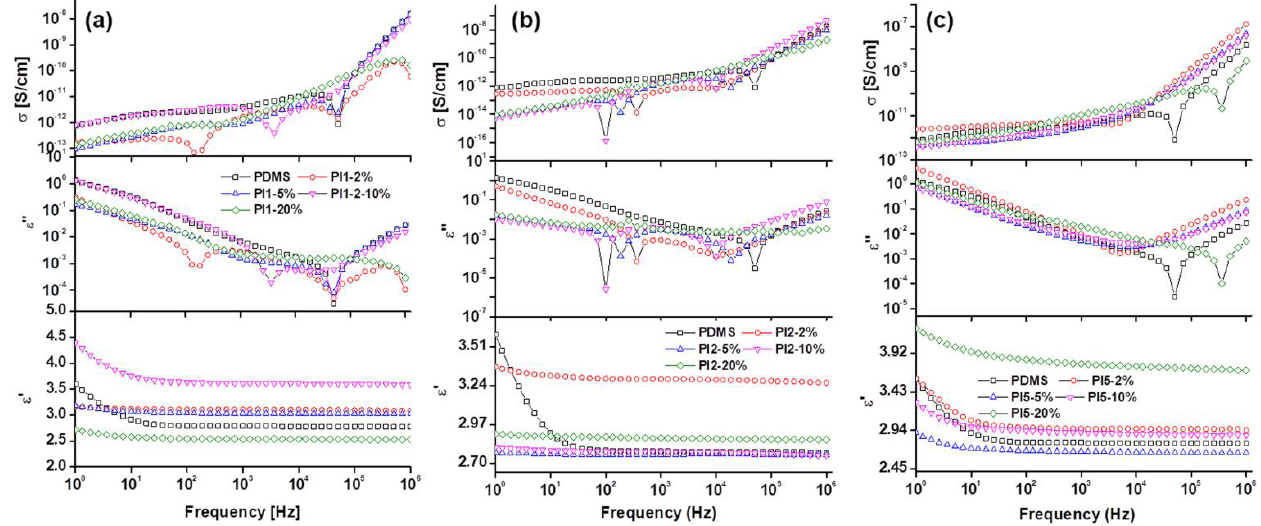
Figure 5. Dielectric properties of the tes ted films including relative permittivity (ε′ ), dielectric loss (ε″ ), and conductivity (σ) for samples prepared with PI1 ( a ), PI2 ( b ), and PI5 ( c ). ( ε (cid:48)(cid:48) ), and conductivity ( σ ) for samples prepared with PI1 ( a ), PI2 ( b ), and PI5 ( c